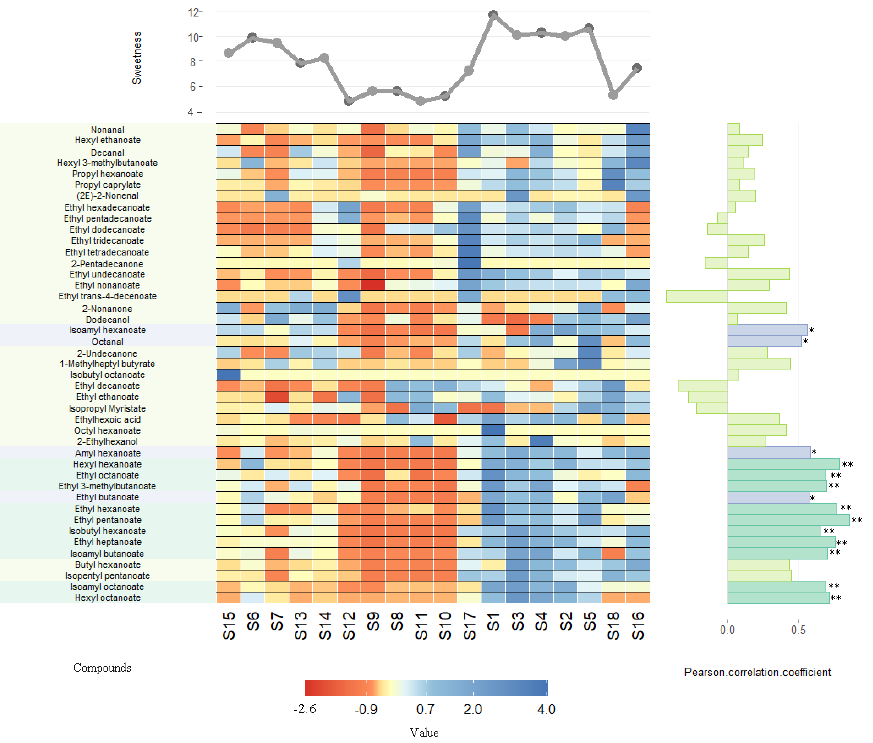
Figure 3. Visualization figure of the correlation between the contents of 43 aroma compounds and sweetness intensity of the 18 Baijiu samples. Compounds: The compounds in Group 1 that are significantly higher concentration (fraction A and fraction B) than in group 2 (fraction C and fraction D) were selected (the data of reactive concentration and visualization figure of these compounds are shown in Table S3 and Figure 2). Sweetness: the sweetness intensities of the 18 Baijiu samples. Value: The value is a normalized value of relative concentration of 43 compounds, which were visualized by heatmap. Pearson correction coefficient (PCC): a value was used to indicate the correlation between the concentration of compounds and sweetness—** highly significant positive correlation (PCC ≥ 0.6), * significant positive correlation (PCC ≥ 0.5).